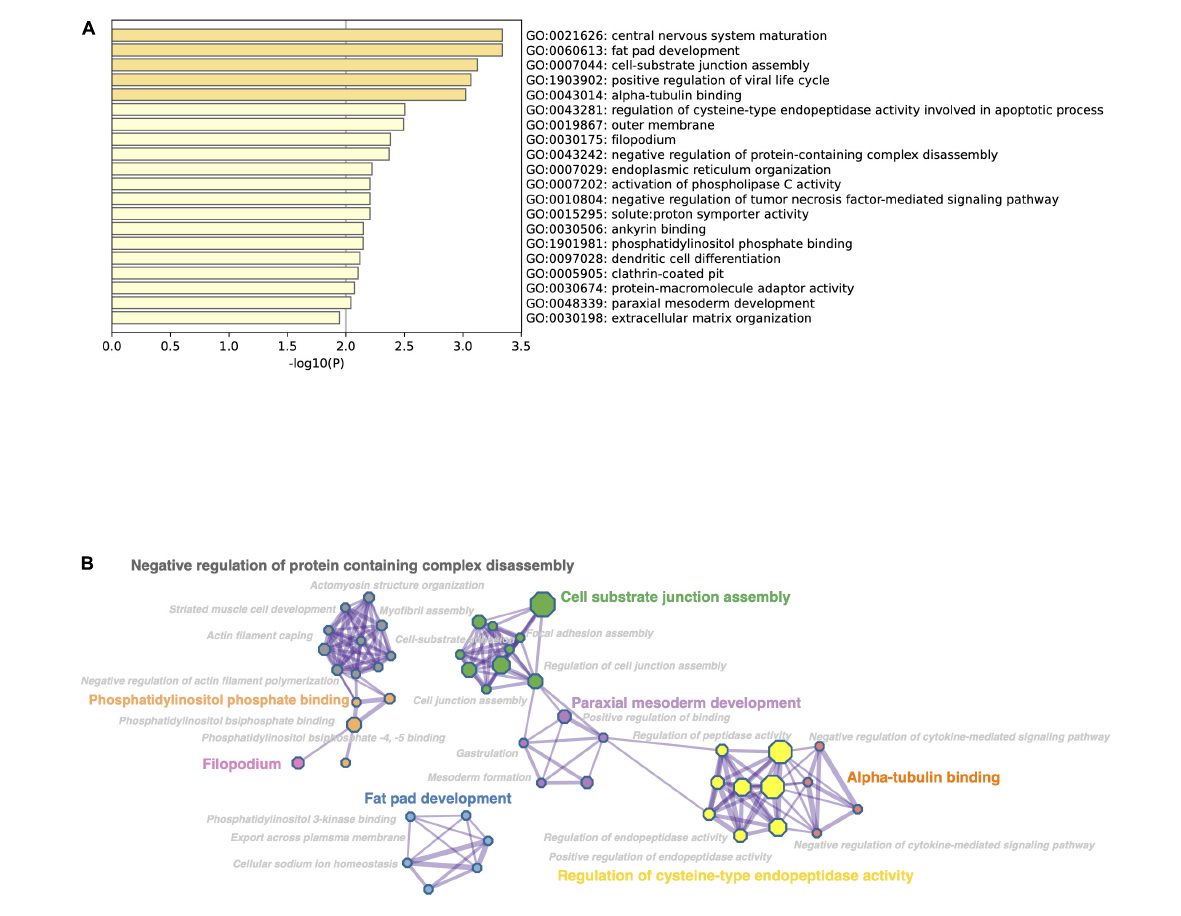
FIGURE3 (A) Bar graph of enriched gene ontology (GO) terms across input gene list, colored by p -values. (B) Subset of enriched terms selected to create a network analysis. Terms with a similarity > 0.03 are connected by edges. Bigger nodes represent larger gene sets. The analyzes were performed in Metascape and visualized with the Cytoscape